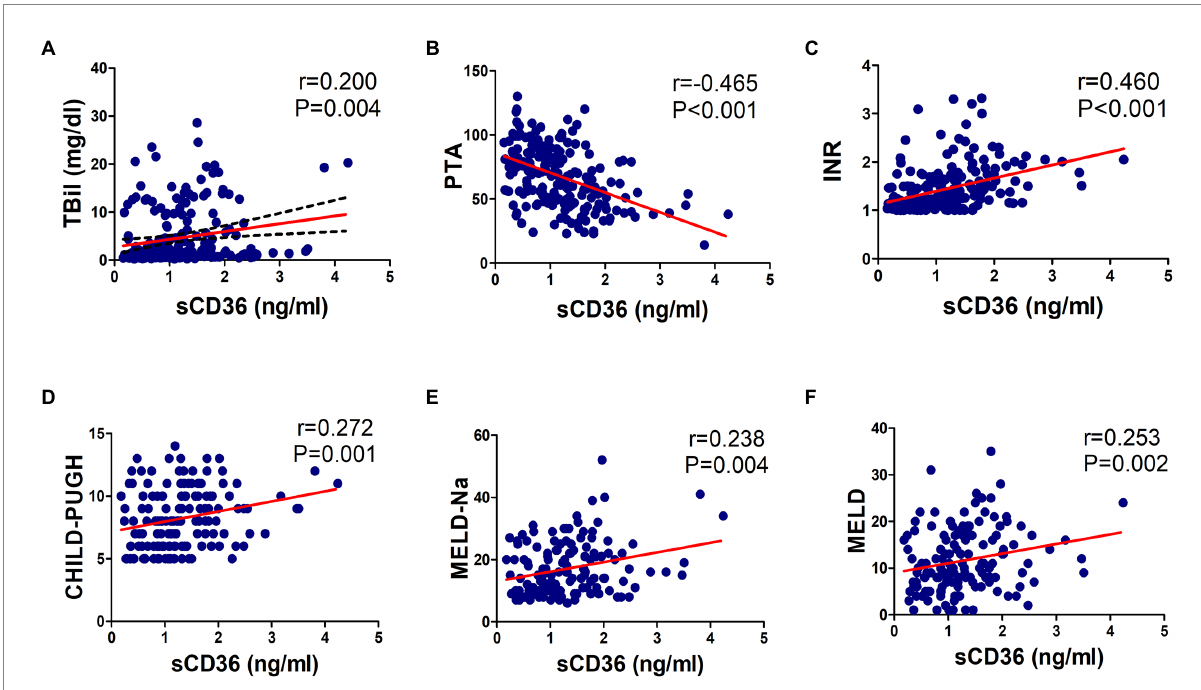
FIGURE 5 Correlation analysis between sCD36 and prognosis. In HBV-infected patients, the correlation between plasma sCD36 and (A) total bilirubin (TBil), (B) prothrombin activity (PTA), (C) international normalized ratio (INR). And in HBV-LC patients, the correlation between plasma sCD36 and (D) CHILD-PUGH score, (E) MELD-Na score and (F) MELD score. p values were calculated using the Spearman’s rank correlation for non- parametric data or Pearson’s correlation for parametric